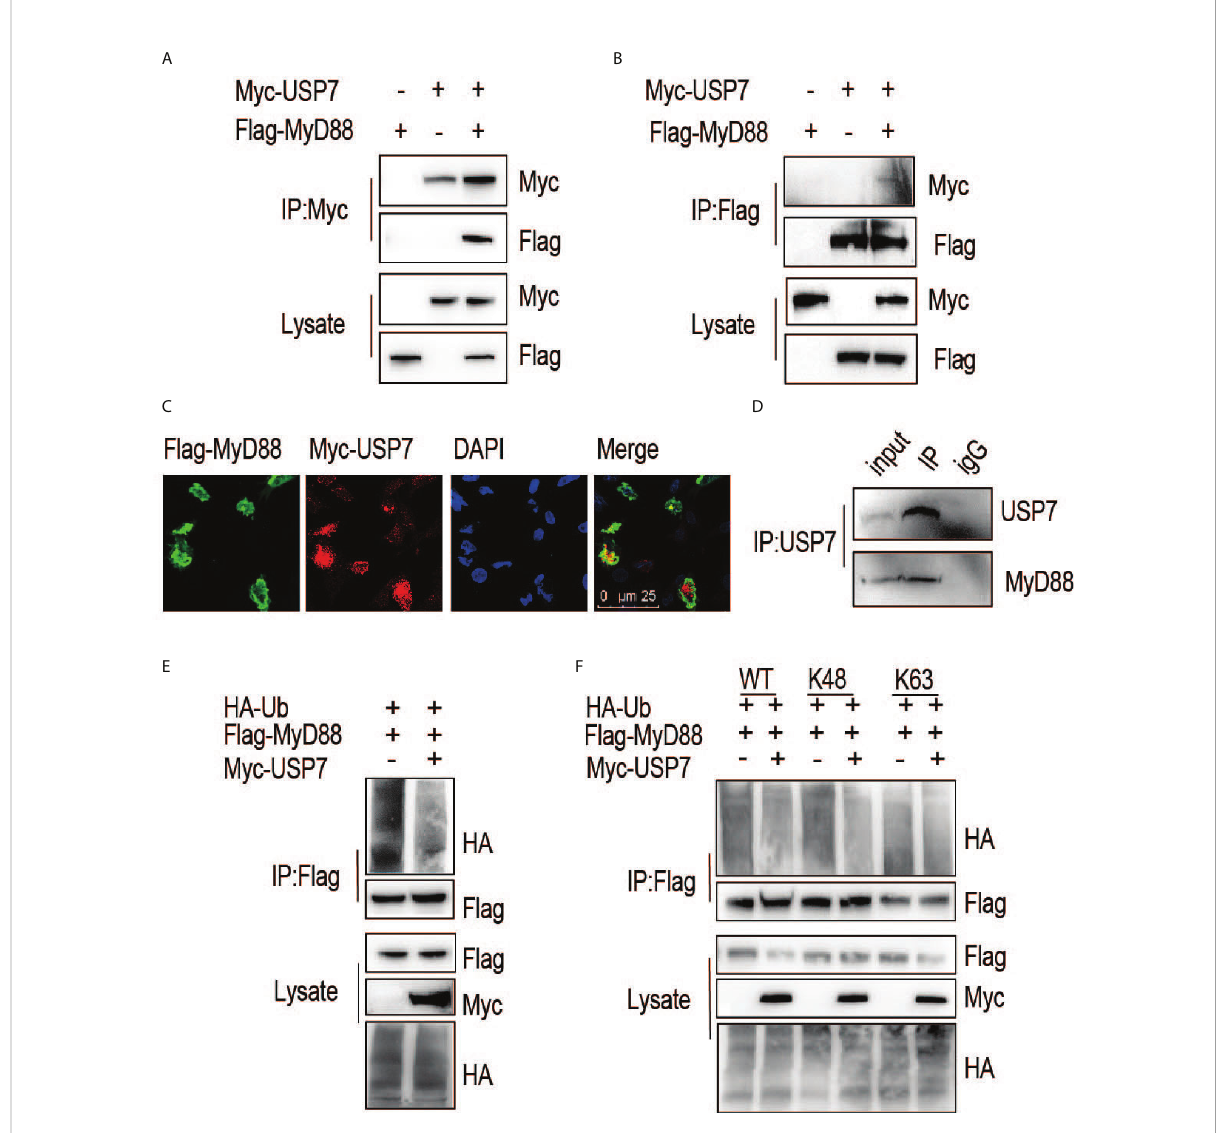
FIGURE 2 ChUSP7 interacts with and promotes K48 linked deubiquitination of chMyD88. Chicken DF1 cells were transfected with the indicated plasmids. Interaction between chMyD88 and chUSP7 was detected by immunoprecipitation using anti-Myc (A) or anti-FLAG (B) antibody, followed by immunoblotting with indicated antibodies. (C) Immuno fl uorescence analysis of chMyD88 and chUSP7. Myc-tagged chUSP7 and FLAG-tagged chMyD88 were transfected into chicken DF1 cells, after which the cells were fi xed and incubated with anti-Myc and anti-FLAG antibodies. Nuclei were stained with DAPI. Confocal microscopy was used to detect the colocalization of chMyD88 and chUSP7. (D) Co- immunoprecipitation of endogenous USP7 and MyD88 in mouse CHO cells. Cell lysates were immunoprecipitated by anti-USP7 or control IgG antibody, followed by immunoblot with indicated antibodies. (E, F) Immunoblot analysis of the ubiquitination level of immunoprecipitated chMyD88 in chicken DF1 cells transfected with the indicated plasmids. Immunoprecipitation was carried out with anti-FLAG antibody, and immunoblots with the indicated